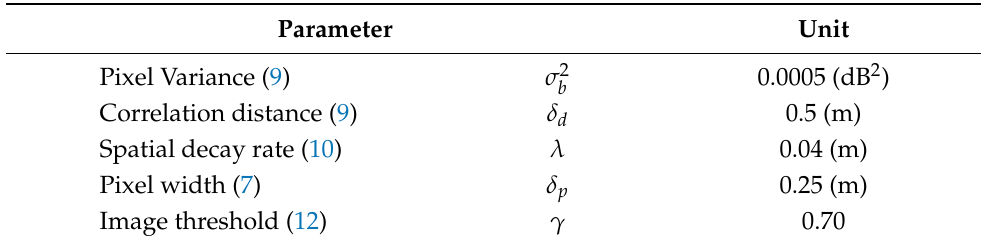
Table 1. Imaging parameters Parameter Unit Pixel Variance